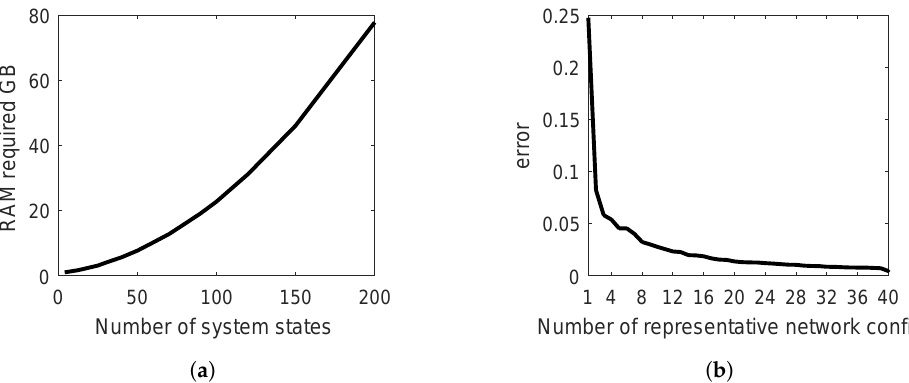
Figure 5. ( a ) The trade-off curve between the number of system states used in the model against the RAM required for execution. ( b ) The trade-off curve between the number of main network configurations against the accumulated